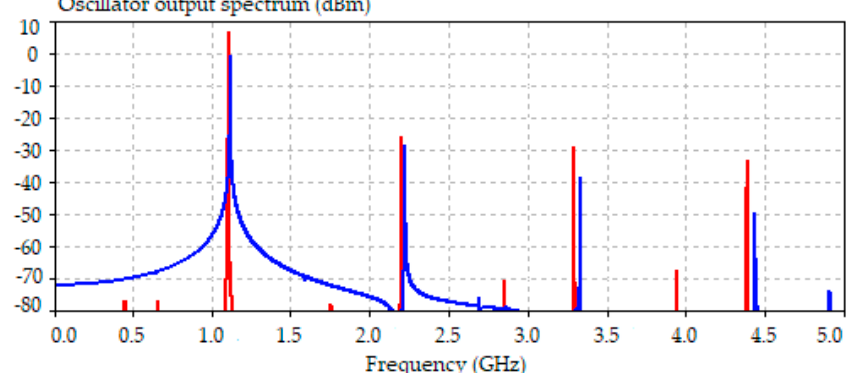
Figure 6. Oscillator output spectrum when C 0 = 1 nF and C F = 5 pF (blue line) and C 0 = 10 µ F and C F = 10 pF (red line).